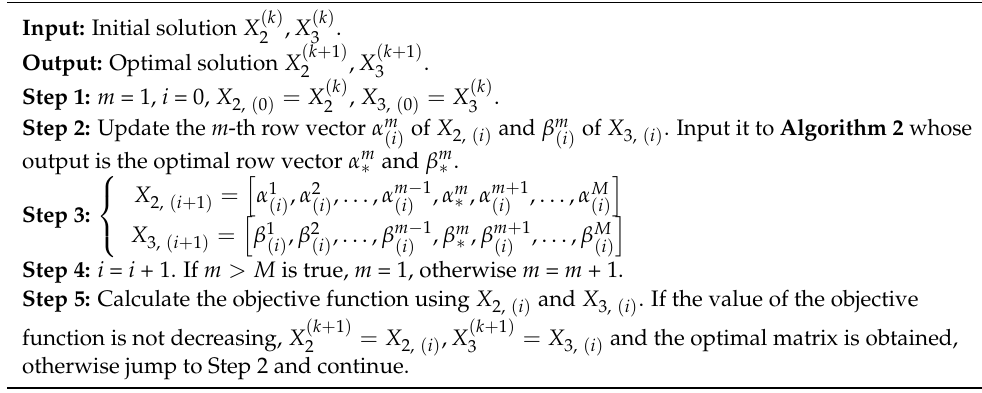
Algorithm 1: Block coordinate descent algorithm for X 2 and X